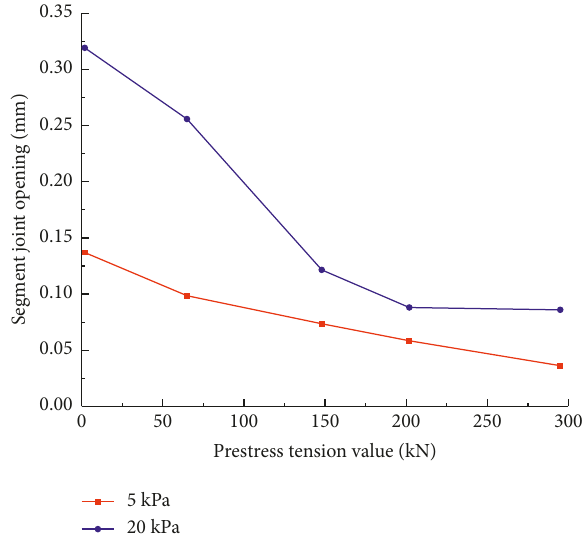
Figure 17: Relationships between segment joint opening and prestress control